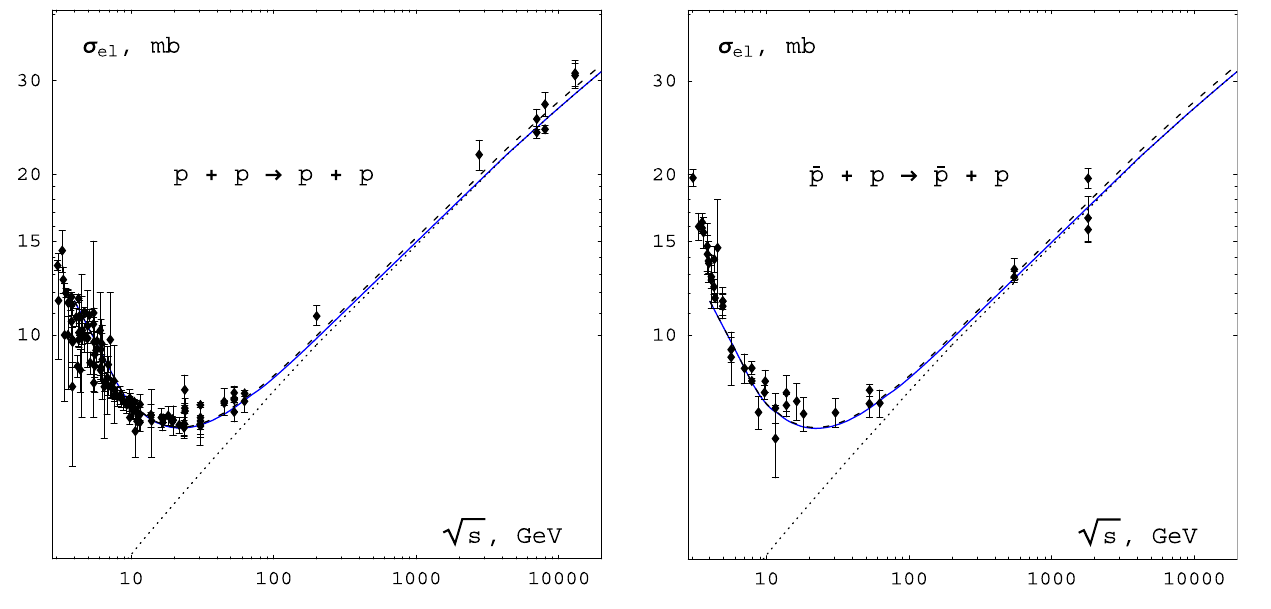
Fig. 6 The integrated cross-sections of nucleon–nucleon EDS. The solid lines correspond to the two-Reggeon eikonal model. The dashed lines are related to the three-Reggeon approximation, wherein the HP